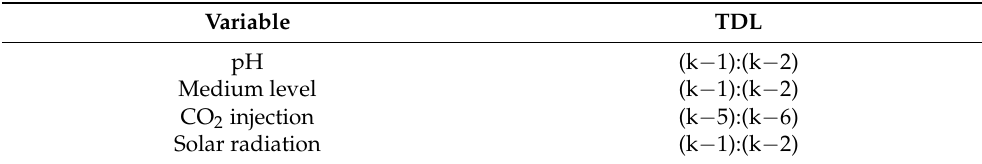
Table 3. TDLs applied to each model